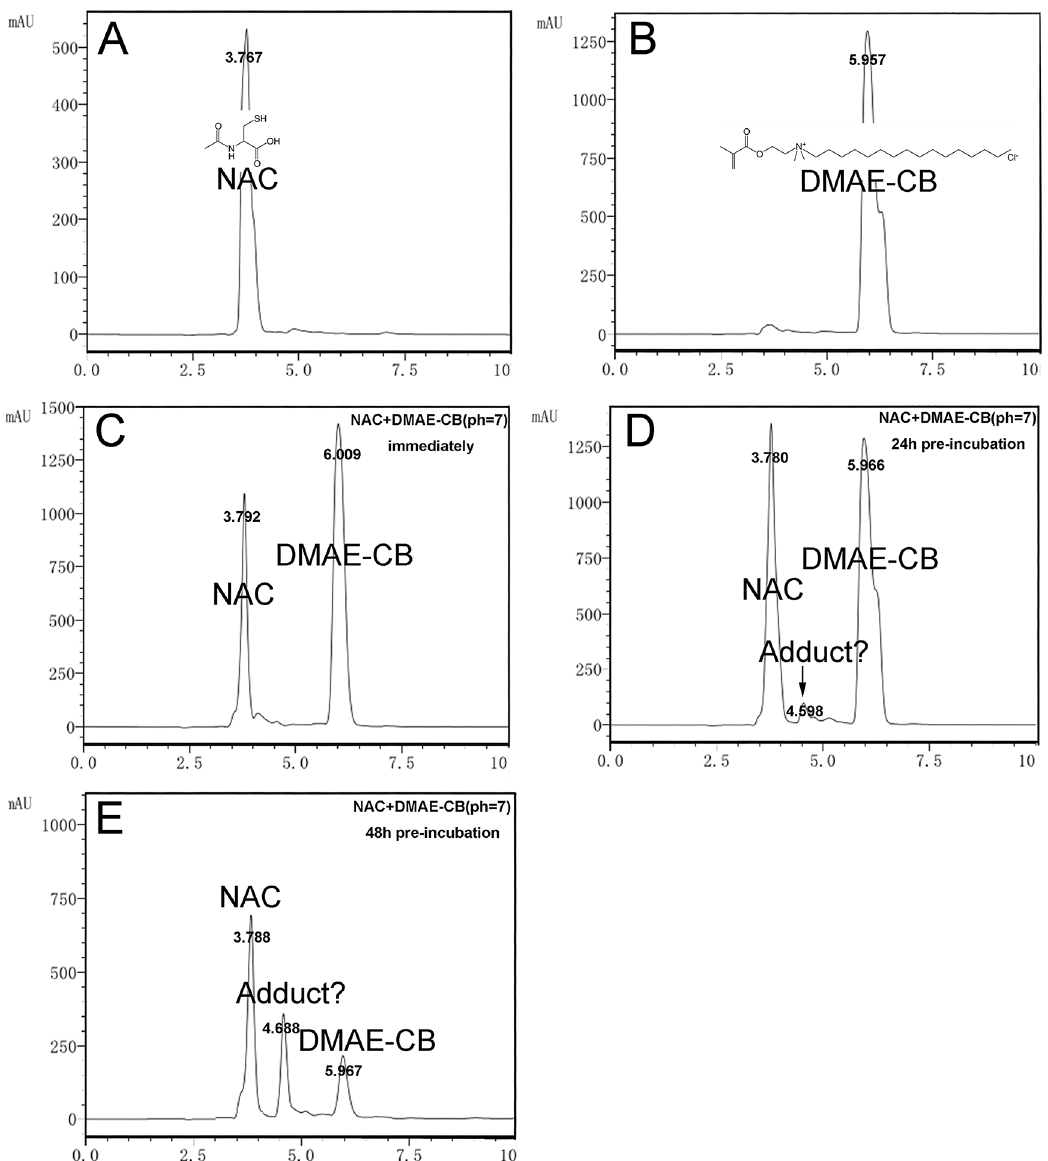
Fig 1. Analysis of the NAC-DMAE-CB adduct using HPLC. NAC (A) or DMAE-CB (B) solution was first analyzed alone. Then, analysis of the mixtures of NAC and DMAE-CB was performed immediately after preparation (C), or after 24 h (D) or 48 h (E) of pre-incubation.